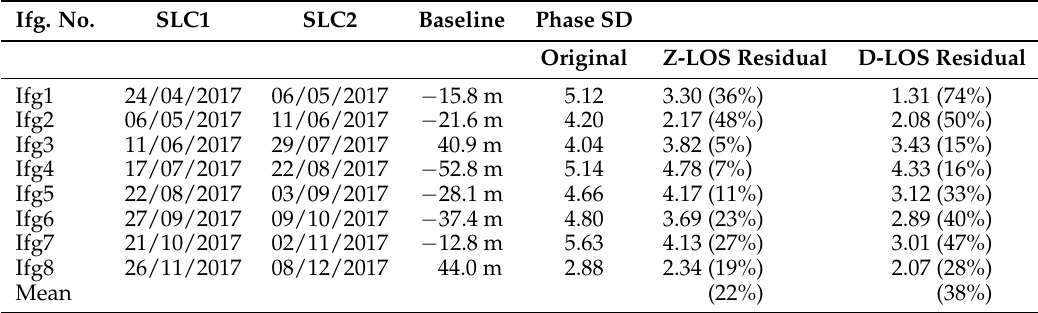
Table 2. Statistical comparison of different mitigation methods for 8 Sentinel-1 interferograms used in Crete, Greece. Values in parentheses are the correction percentage of (original-residual)/original. Ifg. No. SLC1 SLC2 Baseline Phase